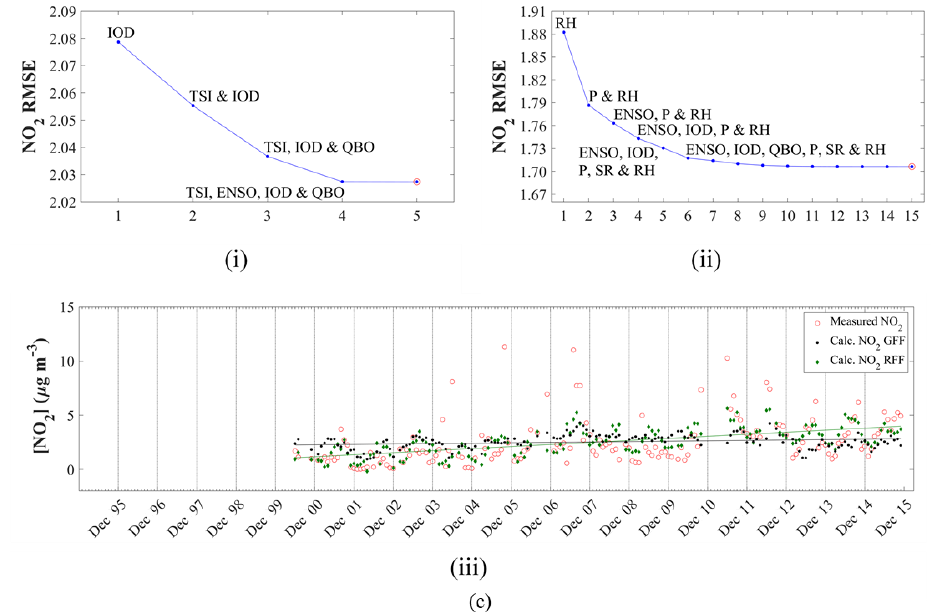
Figure 10. (i, ii) RMSE differences between modelled and measured NO 2 concentrations as a function of the number of independent variables included in the model, as well as a comparison between modelled and measured NO 2 levels (iii) for global force factors only (GFF) and for global, regional and local factors (RFF) determined for AF (a) , LT (b) and SK (c) . Table 2. Regression coefficients ( b ) and relative-importance weight percentage (RIW%) of each independent variable included in the MLR model to calculate NO 2 concentrations at AF, LT and